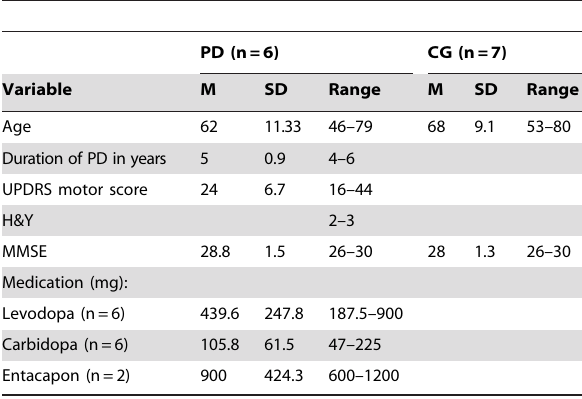
Table 2. Demographic and clinical characteristics of PD and control group for the long-term retention session.